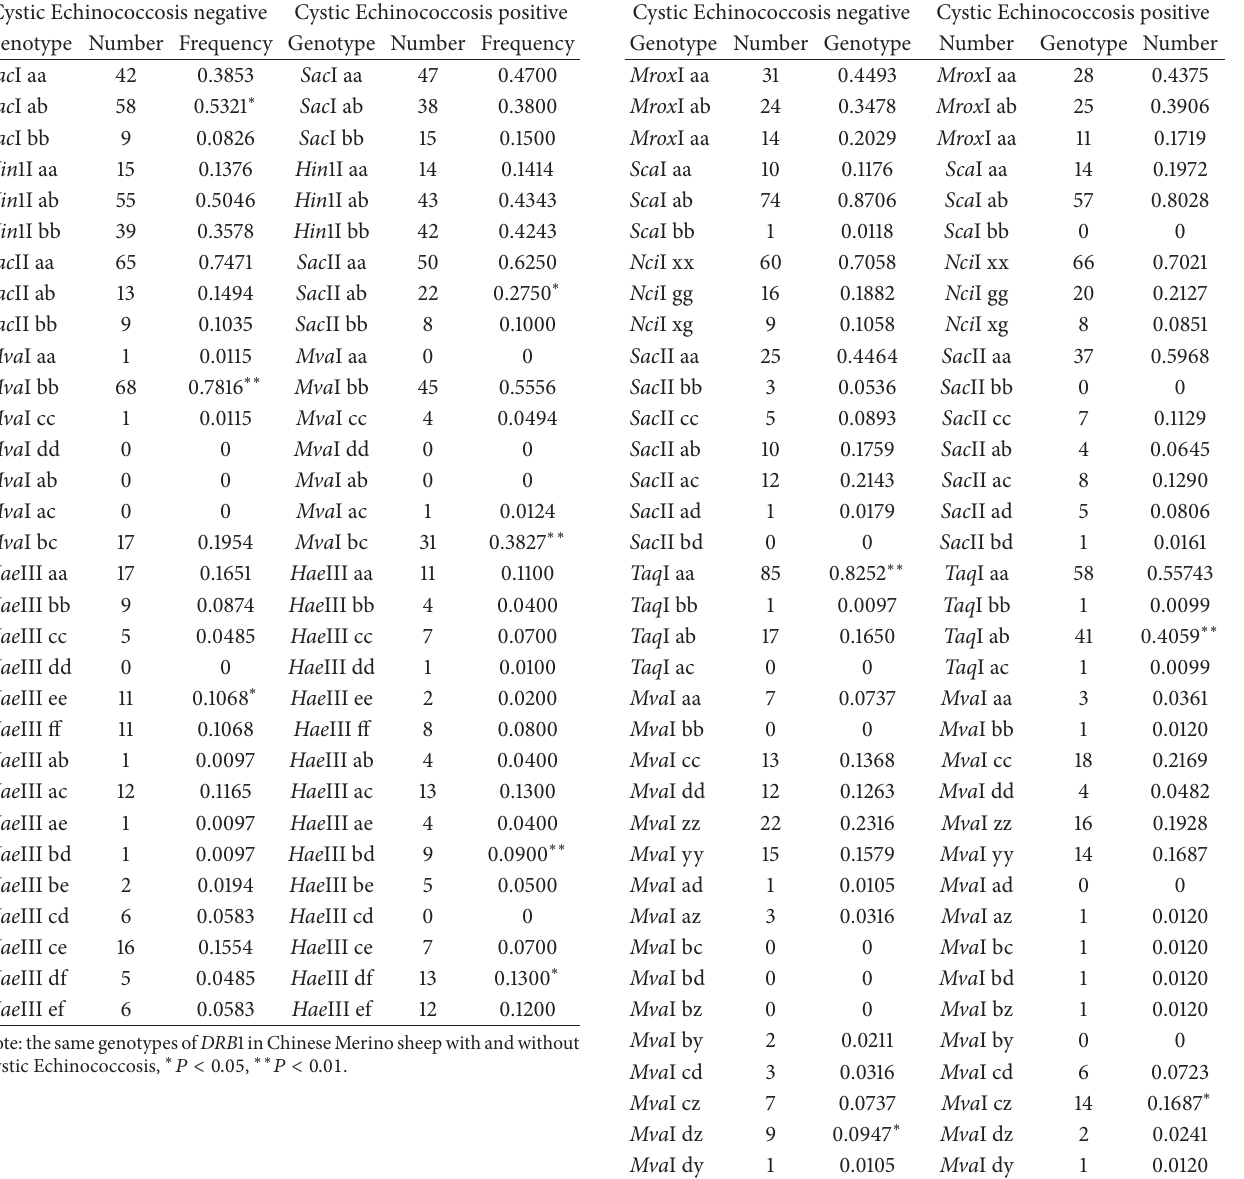
Table 1: Genotypic frequencies of DRB 1 in Chinese Merino sheep with and without Cystic Echinococcosis.